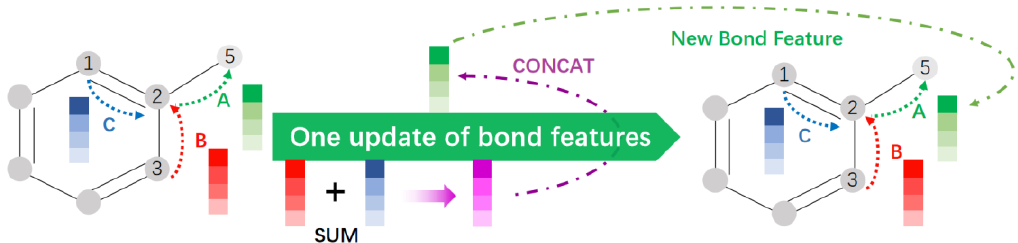
Figure 5. Update of key feature information in D-MPNN.